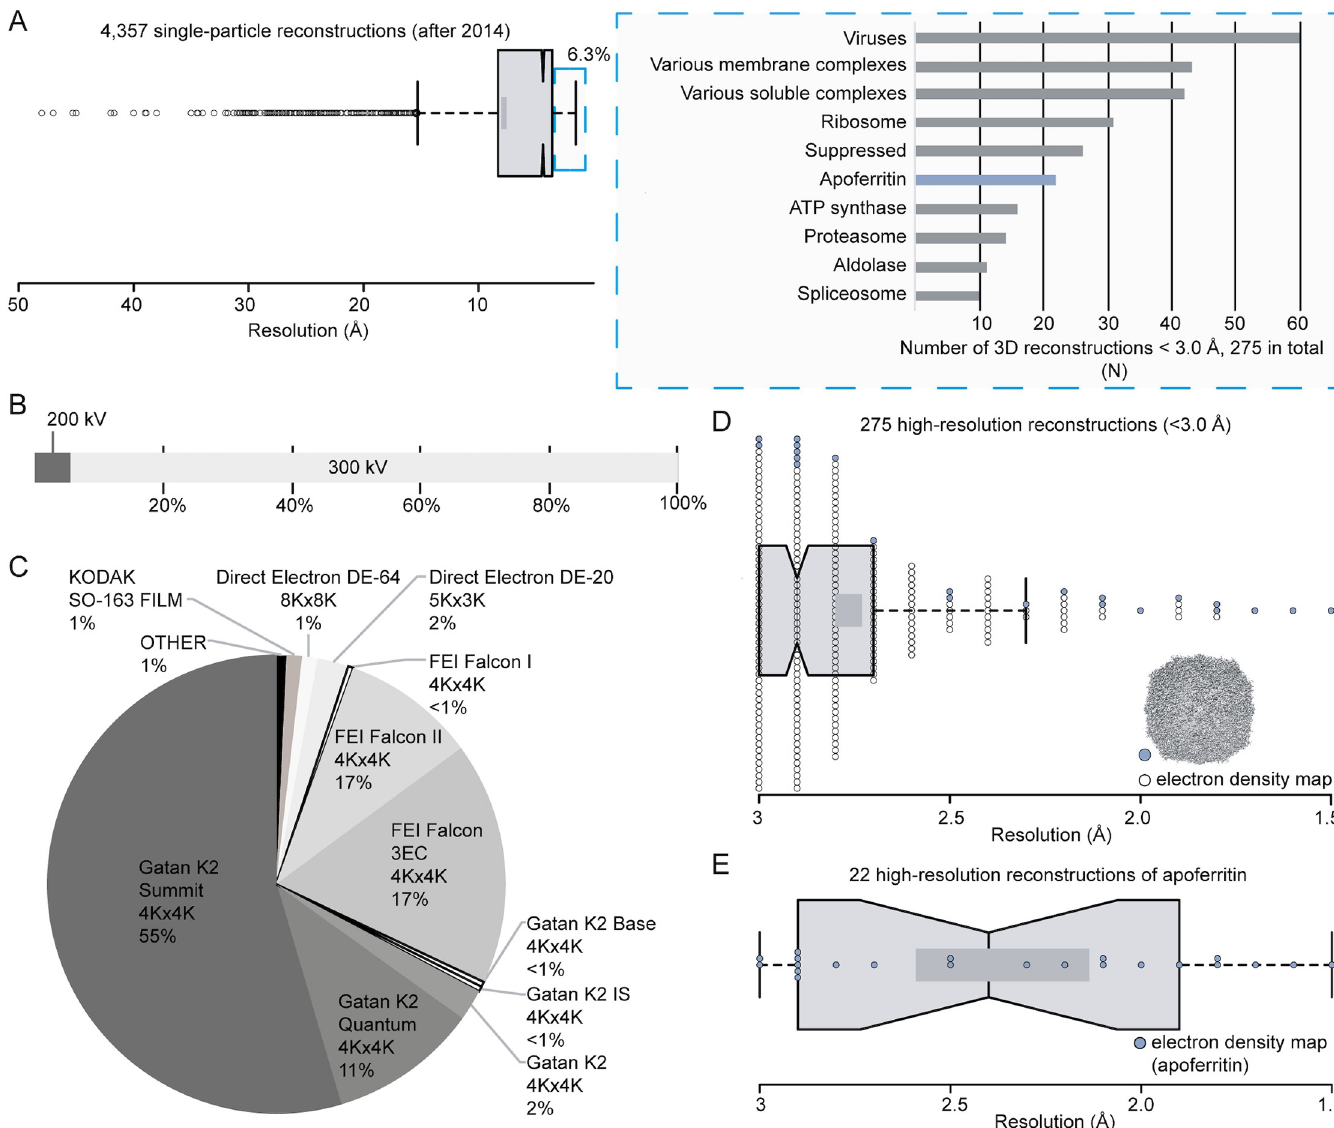
Fig 1. Analysis of single-particle cryo-EM structures from EMDB. (A) On the left, box plot shows the distribution of resolution in all single-particle reconstructions after 2014 and on the right, a bar plot shows the type of specimen reaching resolution better than 3.0 Å ; (B) Percentage of structures reaching resolution better than 3.0 Å according to the electron microscope accelerating voltage used to acquire micrographs; (C) A pie chart showing the detector types applied for deriving molecular structures better than 3.0 Å ; (D) A box plot showing the distribution of resolution for structures better than 3.0 Å ; apoferritin reconstructions are highlighted in blue; (E) A box plot showing the distribution of resolution for apoferritin reconstructions. Dark grey rectangles in (D) and (E) show the confidence intervals at 83%; middle black line shows the average. Data points are shown with circles.